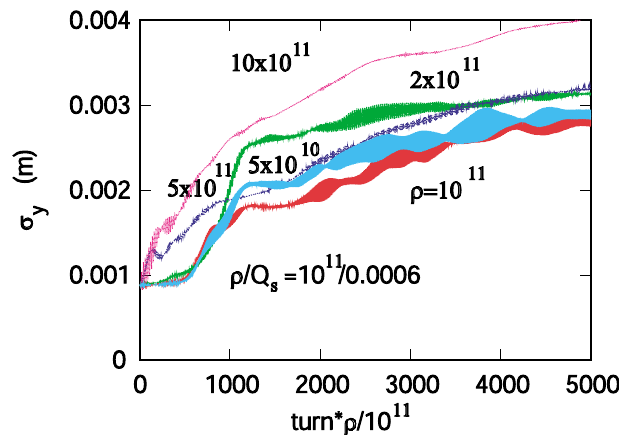
FIG. 42. (Color) Vertical rms beam-size growth of a KEKB bunch over 500 turns for different values of chromaticity Q simulated by the HEADTAIL code [85].